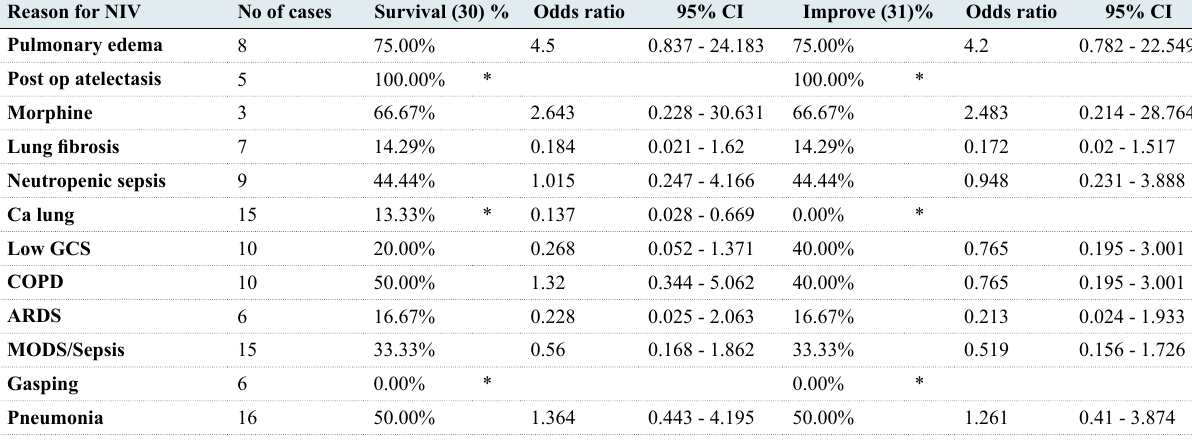
Table 1: Primary reason for initiation of